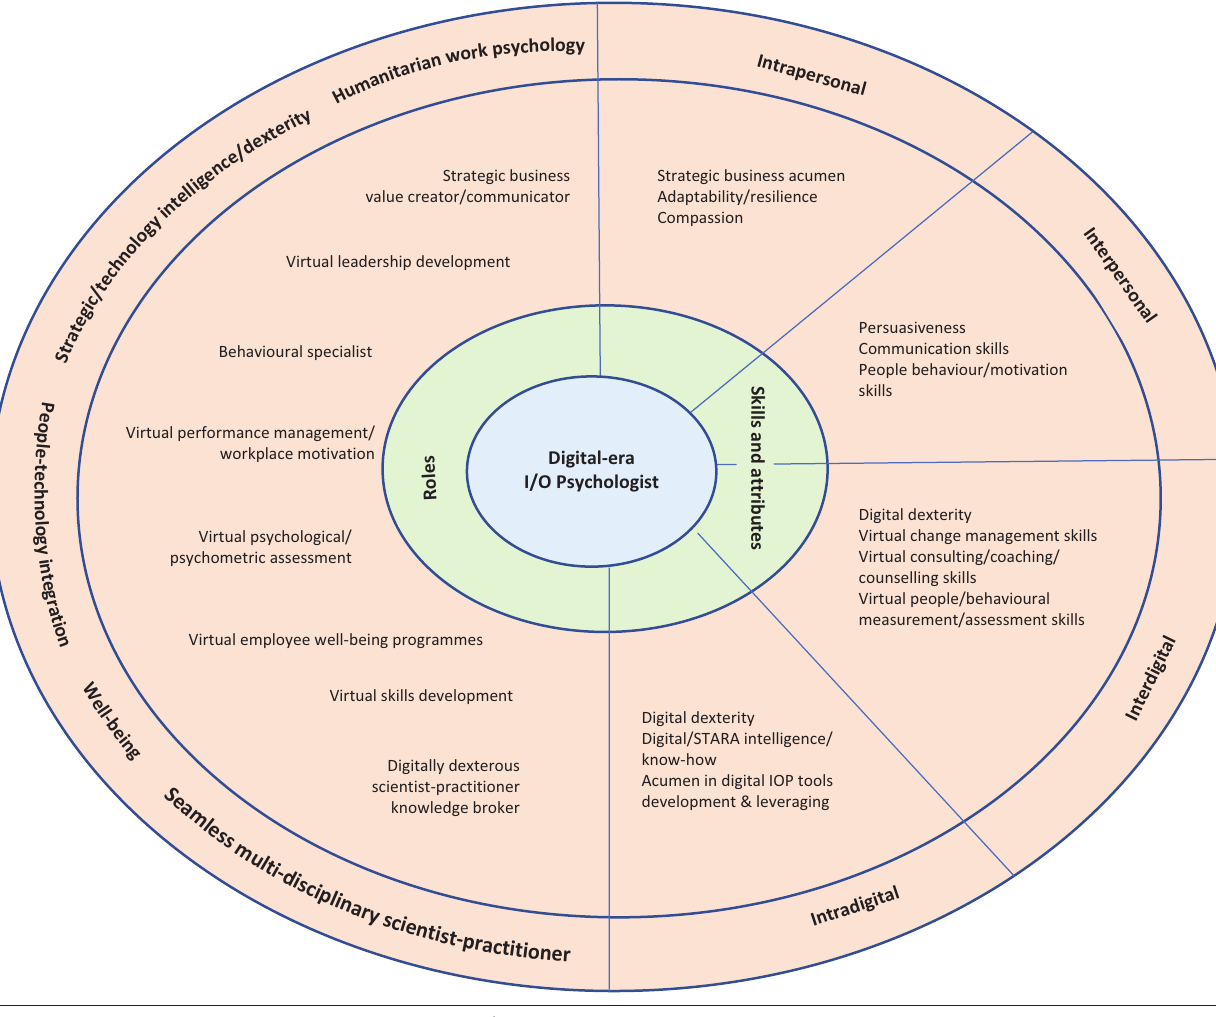
FIGURE 1: Key roles, skills and attributes of the digital-era industrial/organisational psychologist. I/O,